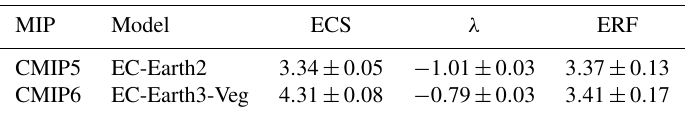
Figure 1. Time series of Q net (a) and T2m (b) in a pre-industrial simulation with CMIP5 aerosols and without explicit cloud droplet activation. The model is not tuned for this configuration and, therefore, experiences a drift over time. The linear regression (solid) in the Q net and T2m plot provides the offset and drift correction that are later subtracted from the 4xCO2 experiment with the same model configuration. The first 5 years (marked using circles in the plot) are excluded when computing the linear fit. (c) A Gregory plot from the 4xCO2 experiment for the same model configuration after correcting for offset and drift in the corresponding experiment with pre-industrial forcing. A regression line is fitted to the data points (red) and extrapolated, again excluding the first 5 years (marked using circles in the plot). The intersection of this line with the (cid:49)Q net = 0 line is an estimate of the equilibrium temperature response in the 4xCO2 experiment. This value has to be divided by 2 to yield an estimate for the equilibrium climate sensitivity (ECS). Table 2. Equilibrium climate sensitivity (ECS, in K), net feedback parameter ( λ , in Wm − 2 K − 1 ) and effective radiative forcing (ERF, in Wm − 2 ) in the CMIP5 and CMIP6 versions of the EC-Earth